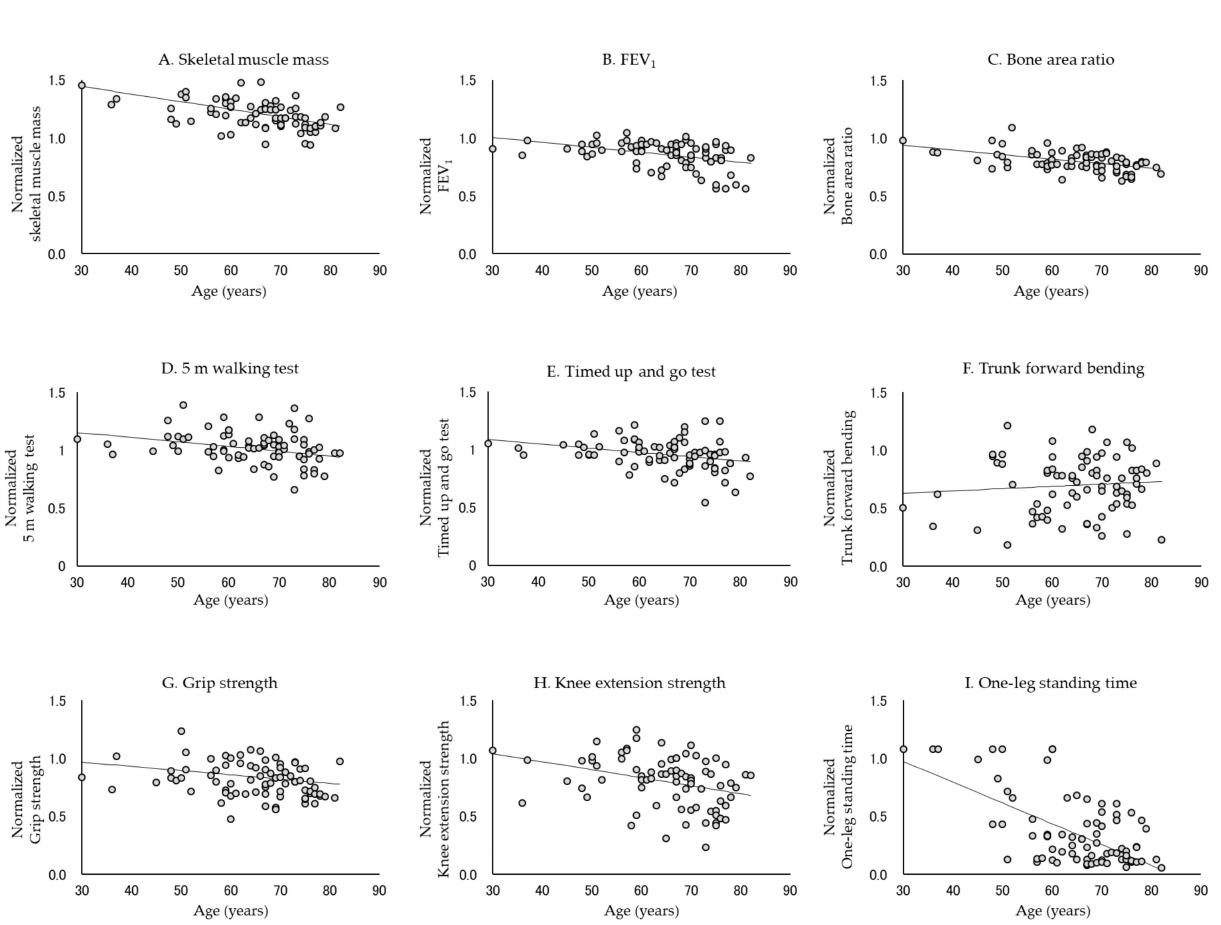
Figure 3. Normalized distribution and linear model of each physical function in women. Each physical function declines with age, except for trunk forward bending. In particular, the rate of decrease in one-leg standing time, knee extension strength, and skeletal muscle mass was high.